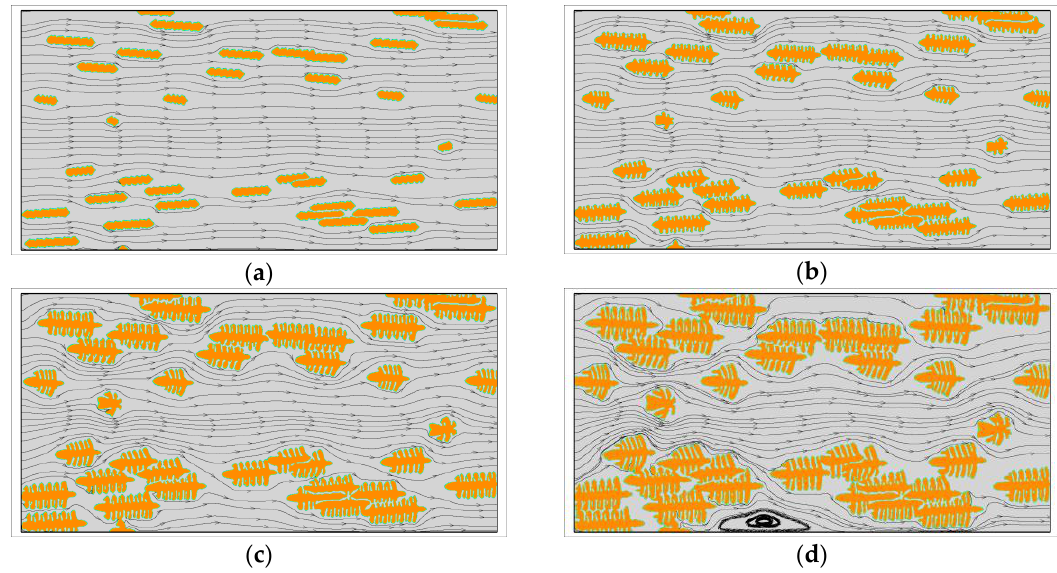
Figure 5. Simulated crystal growth under viscoelastic fluid flow. The simulation contains all the three steps. The strength of the fast flow prior to crystallization is set as ˆ γ = 20. The number and shape of the nuclei are calculated from the nucleation model given in Section 2.2. The viscoelastic fluid flow accompanying the crystal growth has parameters U = 1.0 and We = 1.0. The branching structure is triggered by the anisotropy with the number of mode j = 6 for point-like nuclei and j = 4 for oriented nuclei. ( a ) t = 100; ( b ) t = 200; ( c ) t = 300; ( d ) t =